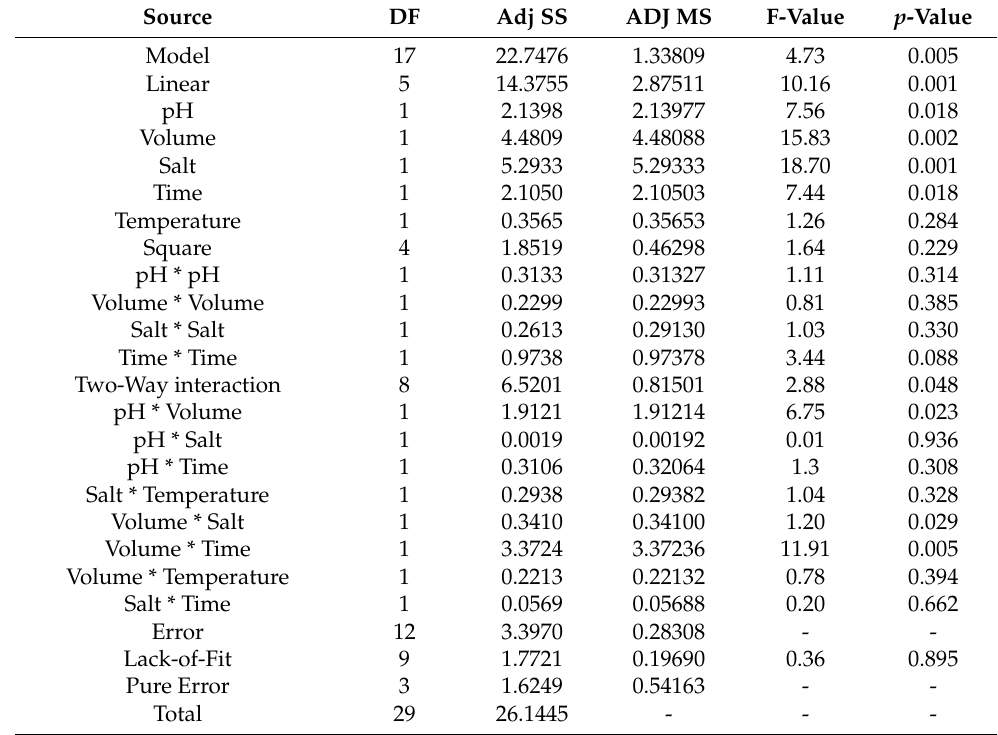
Table 5. Analysis of variance of cotton fabric for DV 09 dye.